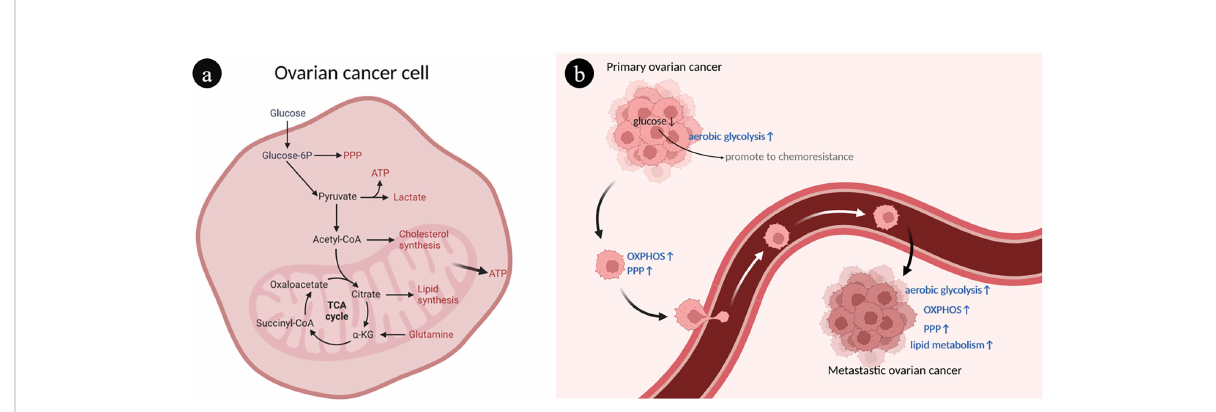
FIGURE 1 Overview of ovarian cancer cell metabolism. (A) Interaction of different metabolic pathways within ovarian cancer cells. There are connections between different metabolisms through metabolites. (B) The heterogeneity of ovarian cancer metabolism is characterized by abnormal glucose and lipid metabolism. During the development of ovarian cancer, different metabolic phenotypes are gradually acquired, such as enhanced OXPHOS, PPP and FAO. ATP, Adenosine triphosphate; FAO, Fatty acid oxidation; OXPHOS, Oxidative phosphorylation; PPP, Pentose phosphate pathway; TCA, Tricarboxylic